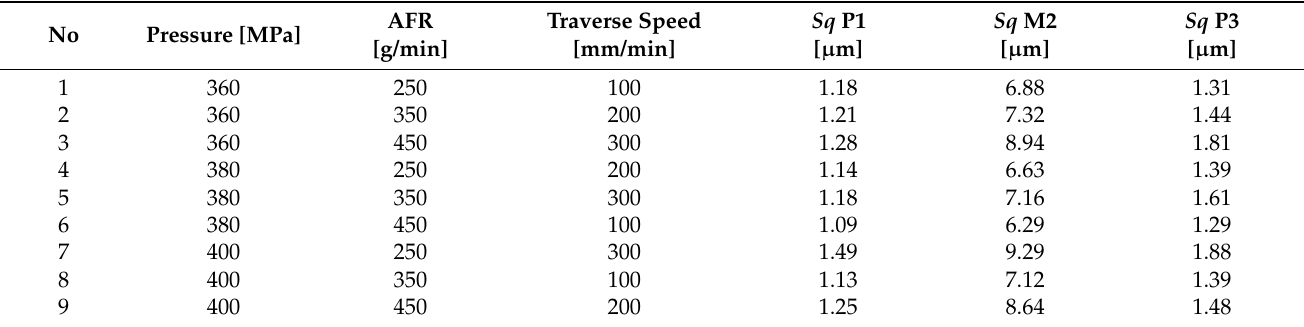
Table 2. Results of tests with the control parameter data.